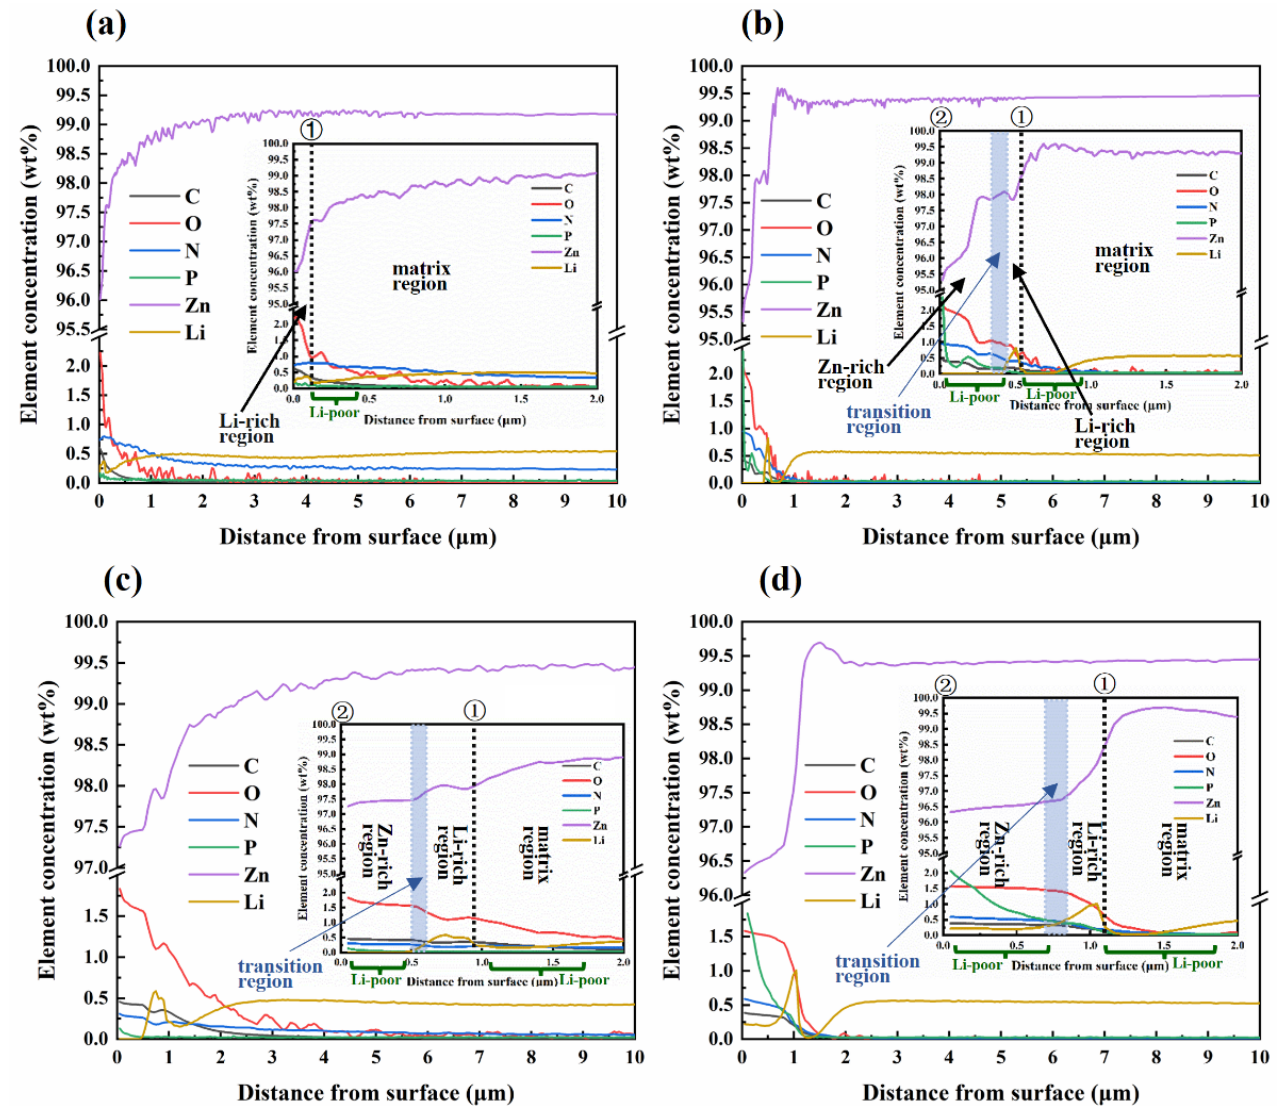
Figure 6. GD-OES depth profiles of Zn–0.4Li immersed in SGF ( a , c ) and SIF ( b , d ). ( a , b ) For 1 day, ( c , d ) for 7 days. ① : interface 1, ② : interface 2. The insert is an enlarged view from the surface of the sample to 2 μ m inside.